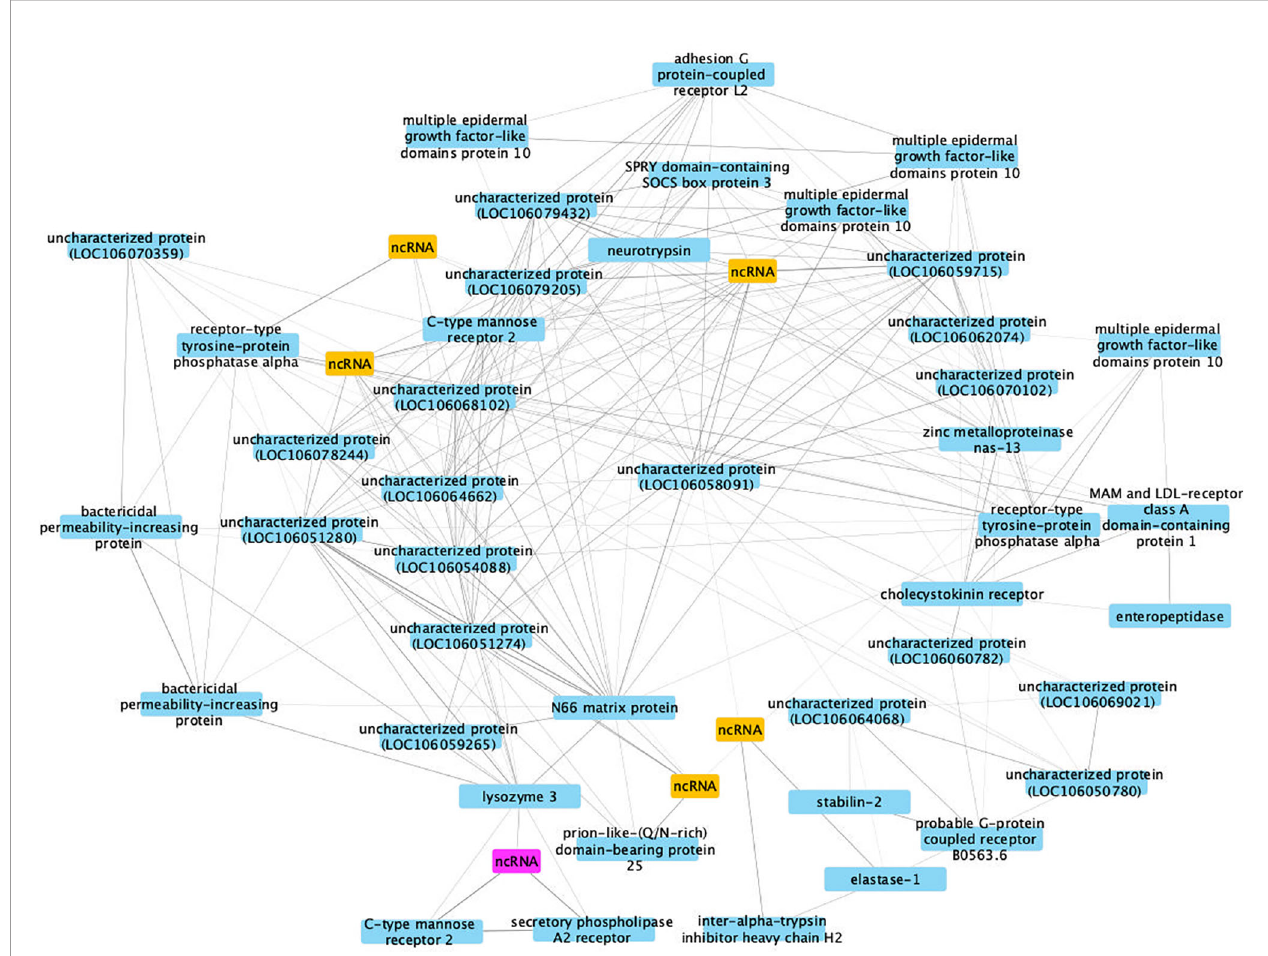
FIGURE 11 | A co-expression network in module #4 of SUS strain with infection-related genes. Protein coding genes including annotated and uncharacterized proteins are in blue boxes; non-coding RNA (ncRNA) genes are in yellow boxes. The ncRNA appearing in both RES and SUS networks was highlighted in